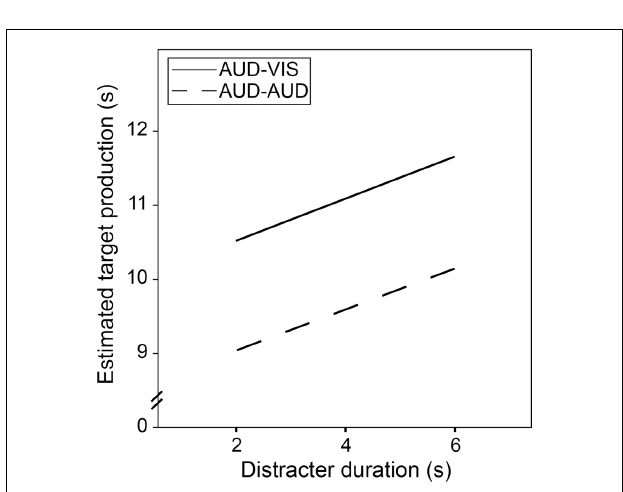
FIGURE 6 | Scatter plots showing the relationship between the square root of the production times of the distracter interval (abscissa) and the square root of the production times of the target interval (ordinate)